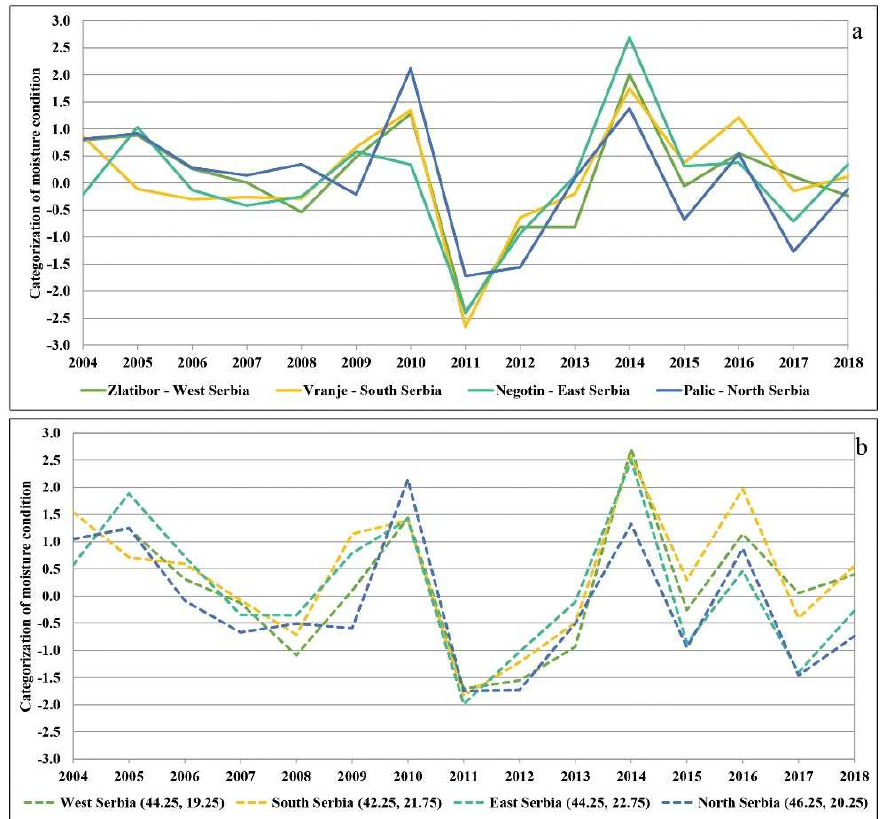
Figure 4. ( a ) SPI-12 for the four major weather stations in the north, west, east, and south of Serbia; ( b ) SPEI-12 for time series in the north, west, east, and south of Serbia.